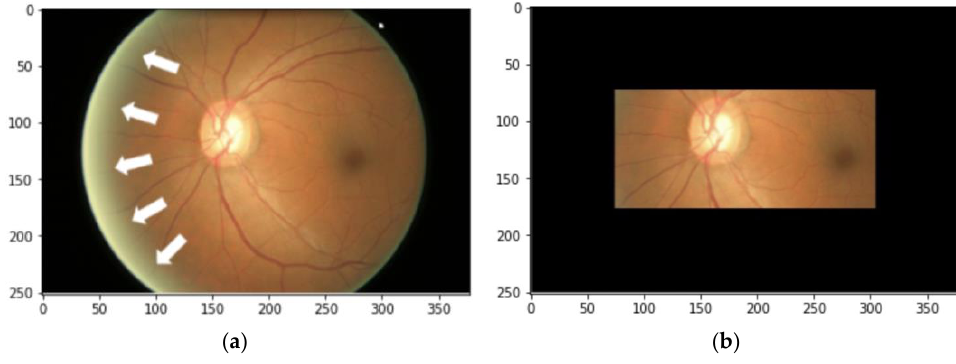
Figure 5. The fringe ( a ) is shown by the white arrows. To eliminate the fringe, a frame ( b ) is added on the side of the image.